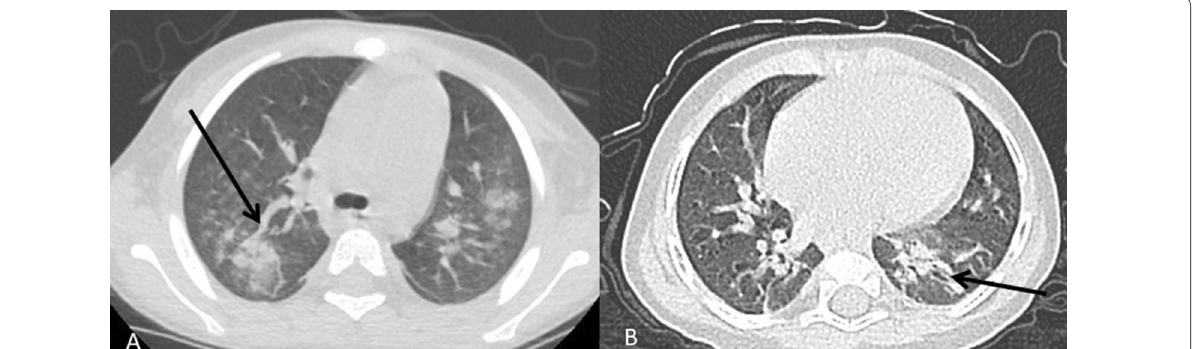
Fig. 2 A A 7‑year‑old male patient with vascular sign (arrow) and B an 8‑month‑old male patient with left lung traction bronchiectasis